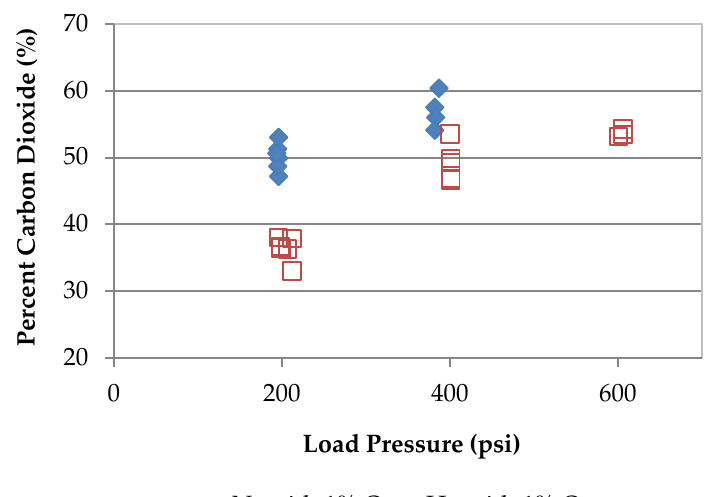
Figure 13. Percent of 11 C recovered as CO 2 for the BN-131 target at 5 μ A.